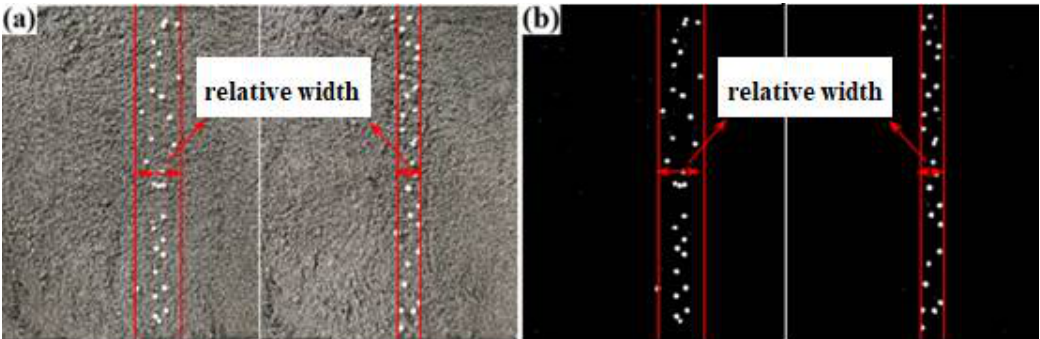
Figure 19. Relative width of soybean seed particles distributed on the soil tray at different relative seed throwing speeds ( a ) graph of test results ( b ) picture of binarization of test